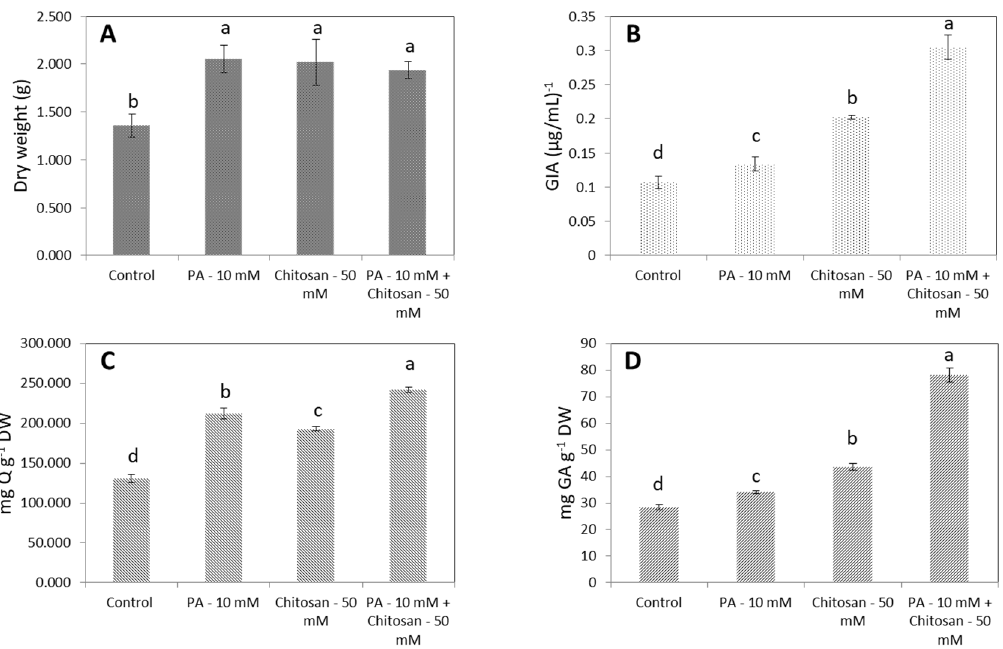
Figure 7. The effects of the combination of PA and chitosan (CS) on AHRs. ( A ) DW, ( B ) GIA, ( C ) FLA ( D ) PHEL. Error bars represent standard deviations. The values in a line marked with different lower-case letters denote significant differences between samples at p < 0.05 (Duncan’s multiple range test).